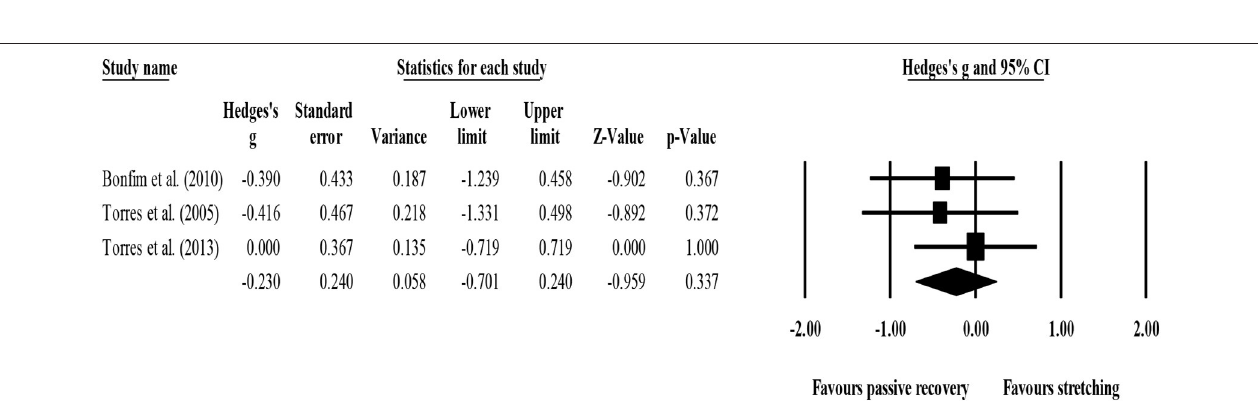
FIGURE 13 | Forest plot denoting 72-h post-exercise delayed onset of muscle soreness (DOMS) in participants that completed post-exercise passive recovery protocols. Values shown are effect sizes (Hedges’s g) with 95% confidence intervals (CI). The size of the plotted squares reflects the statistical weight of each study. The black diamond reflects the overall result. Note: positive values denote that post-exercise passive recovery protocols did not allow participants to recover their basal DOMS level (i.e., 0.00 in the figure).